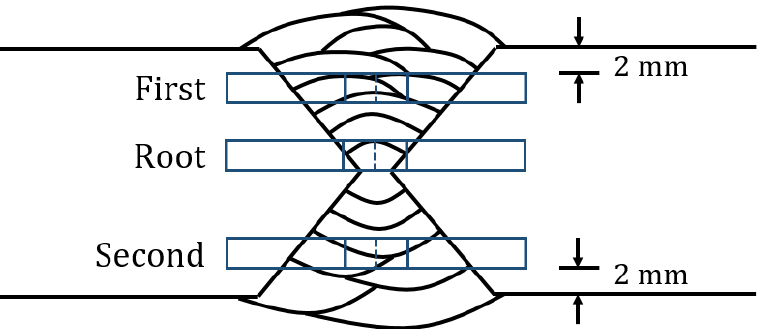
Figure 5. Schematic diagram of sample location for Charpy impact specimen.